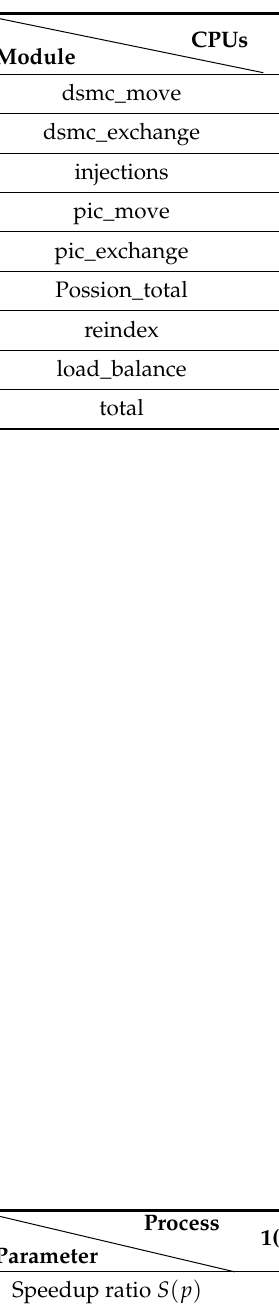
Table 6. Time (unit: s) consumed for parallel computing in the centralized communication strategy.